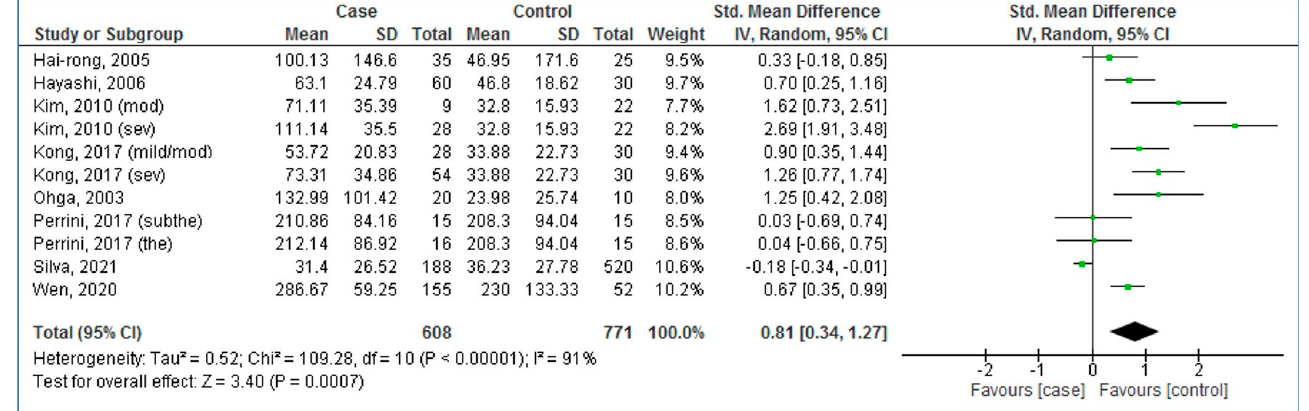
Figure 2. Forest plot analysis comparing blood levels of monocyte chemotactic protein-1 in adults with obstructive sleep apnea compared to controls. CI: Confidence interval. SD: Standard deviation. [21–26,36,37].